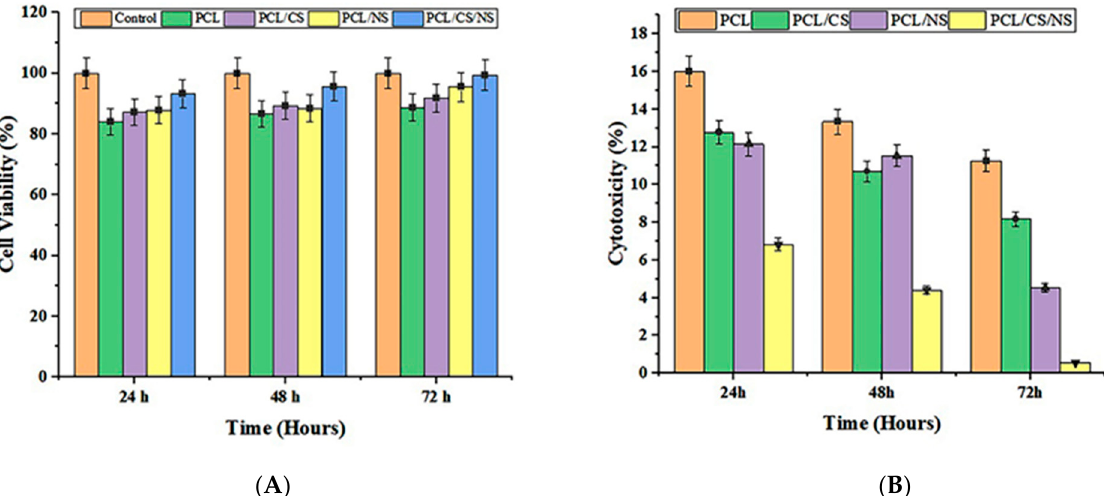
Figure 4. ( A ) L929 cell viability percentages during different periods of time (24, 48, and 72 h). ( B ) L929 cytotoxicity percentages during different periods of time (24, 48, and 72 h).